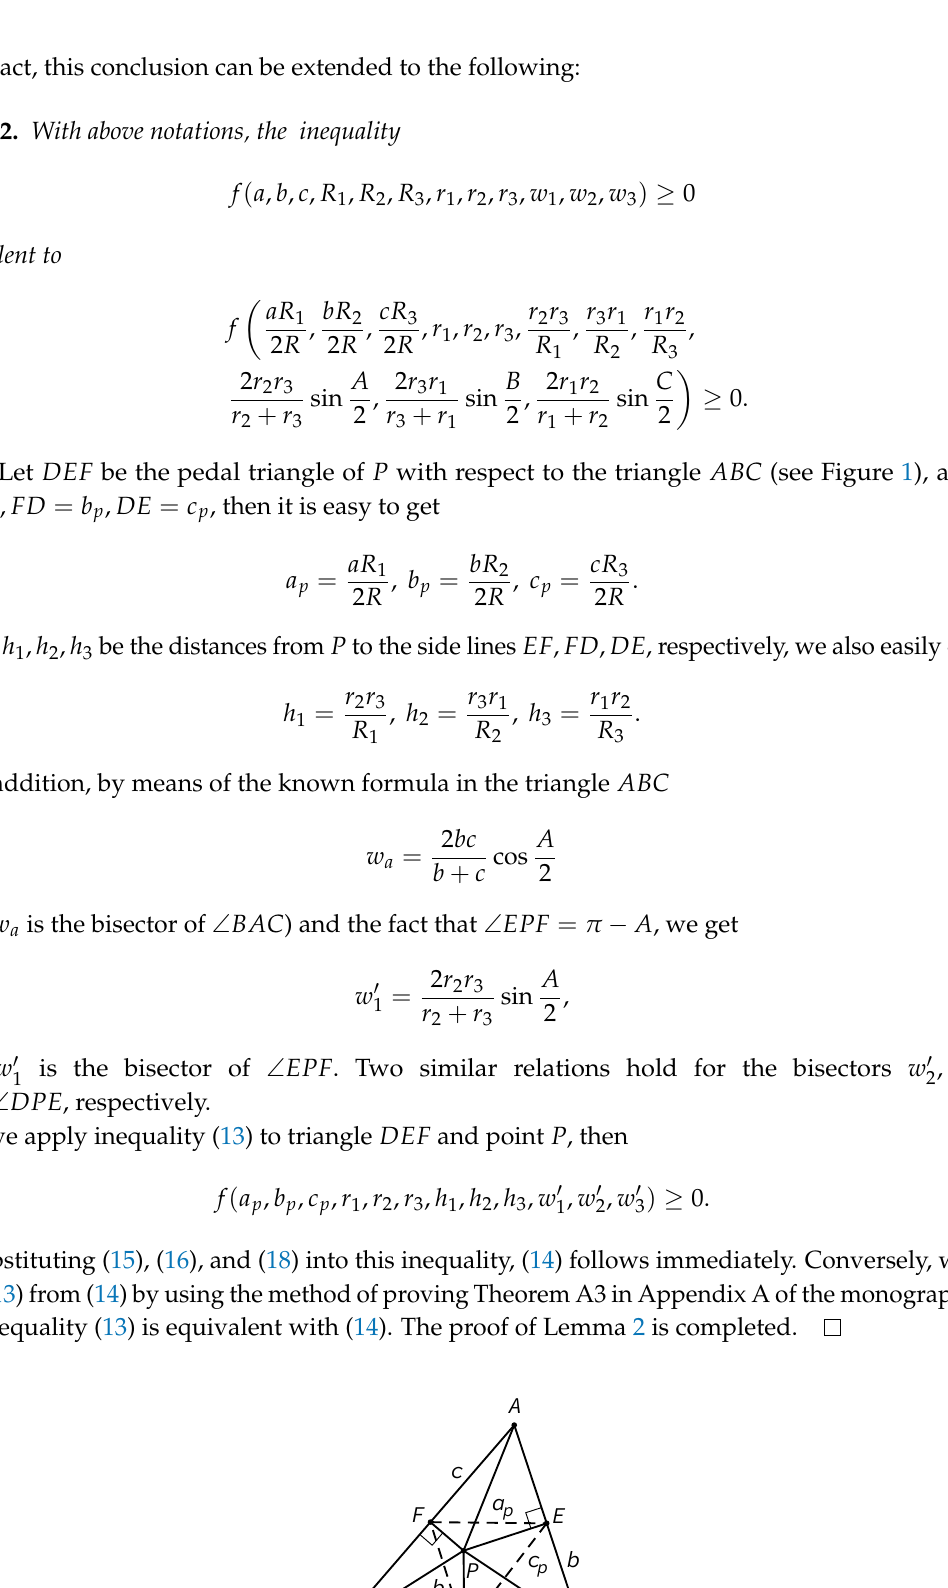
Fig.1 An inequality involving any point P inside triangle ABC is equivalent to the one involving the point P and its pedal triangle DEF with respect to ABC.